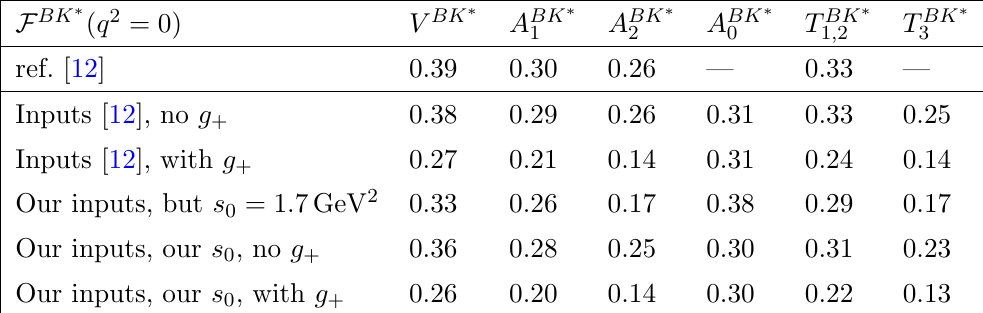
Table 7 . Deconstruction of the di(cid:11)erent e(cid:11)ects explaining the di(cid:11)erence between our results for the form factors at q 2 = 0 and those in ref. [12]. The di(cid:11)erence stems mainly from the inclusion of the twist-four two-particle contributions. See the text for more